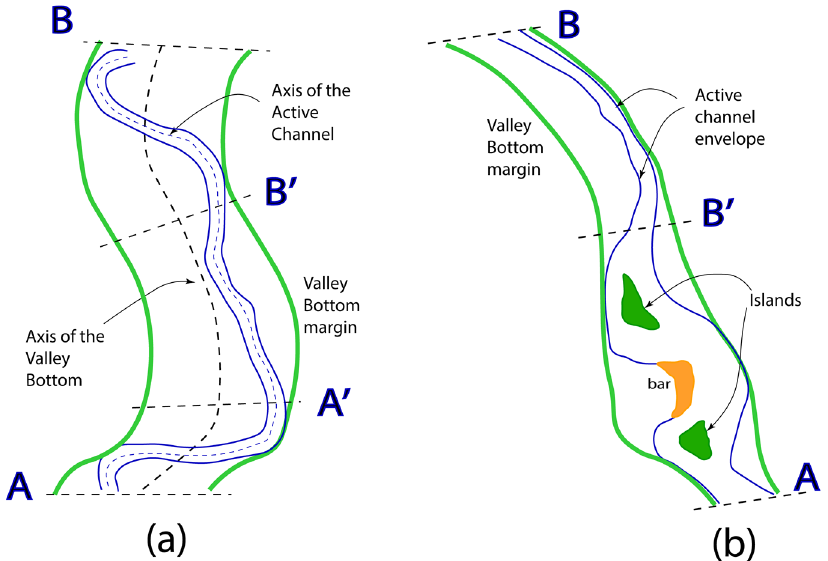
Figure 1. Examples of ambiguity related to extensive attributes. ( a ) Sinuosity of segment A-B is much higher than that of segment A’-B’ which is almost straight; that of A-A’ is even higher; ( b ) Regarding confinement, the whole segment A-B is identified as “partly confined” because along its length more than 10%, but less than 85% of either banks of the active channel is in contact with the VB margin; however, based on planform, two well di ff erent sub segments are identified (A-B’; B’-B) and confinement for segment A-B’ gets the value “confined” (because the total contact length is more than 85%) (definition of confinement according to Brierley and Fryirs, [5]; Fryirs et al. [7]; O’Brien et al. [8]). A similar behavior occurs with other attributes (those concerning the presence of geomorphic units): each time an attribute comes into play, and a further segmentation is introduced, all previously assessed attributes need to be re-assessed possibly producing di ff erent values. In addition, when the channel migrates (adjustment without changing its character), “confinement” may possibly change; since this is the starting point of the River Styles procedural tree, this may produce dramatic changes in the classification and hence significant re-segmentation work.